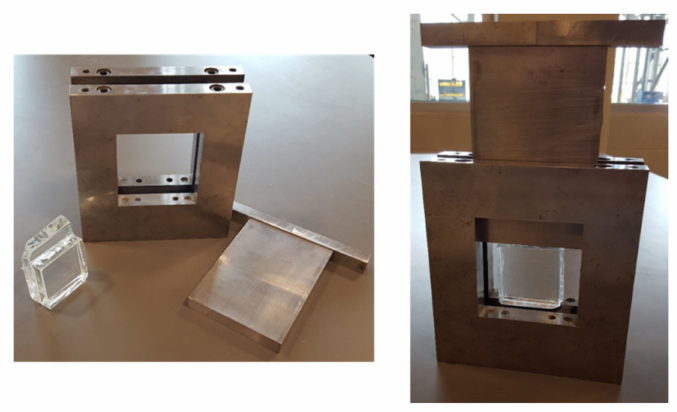
Figure 9. Test jig and sample for preliminary compressive load shear